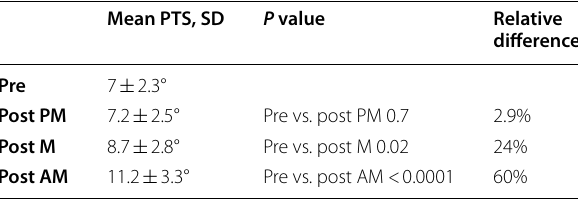
Table 2 Comparison of preoperative and global (3 & 4 cm, n